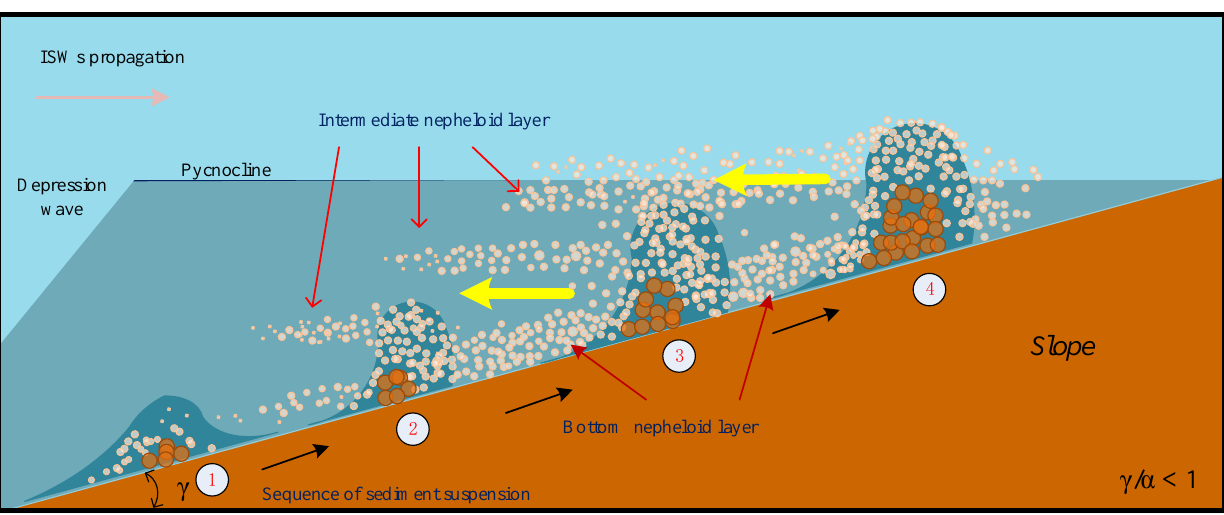
Figure 7. Schematic diagram of the bottom and intermediate nepheloid layers formed by shoaling internal solitary waves in transmissive regions [31]. The sediment resuspended from left to right.